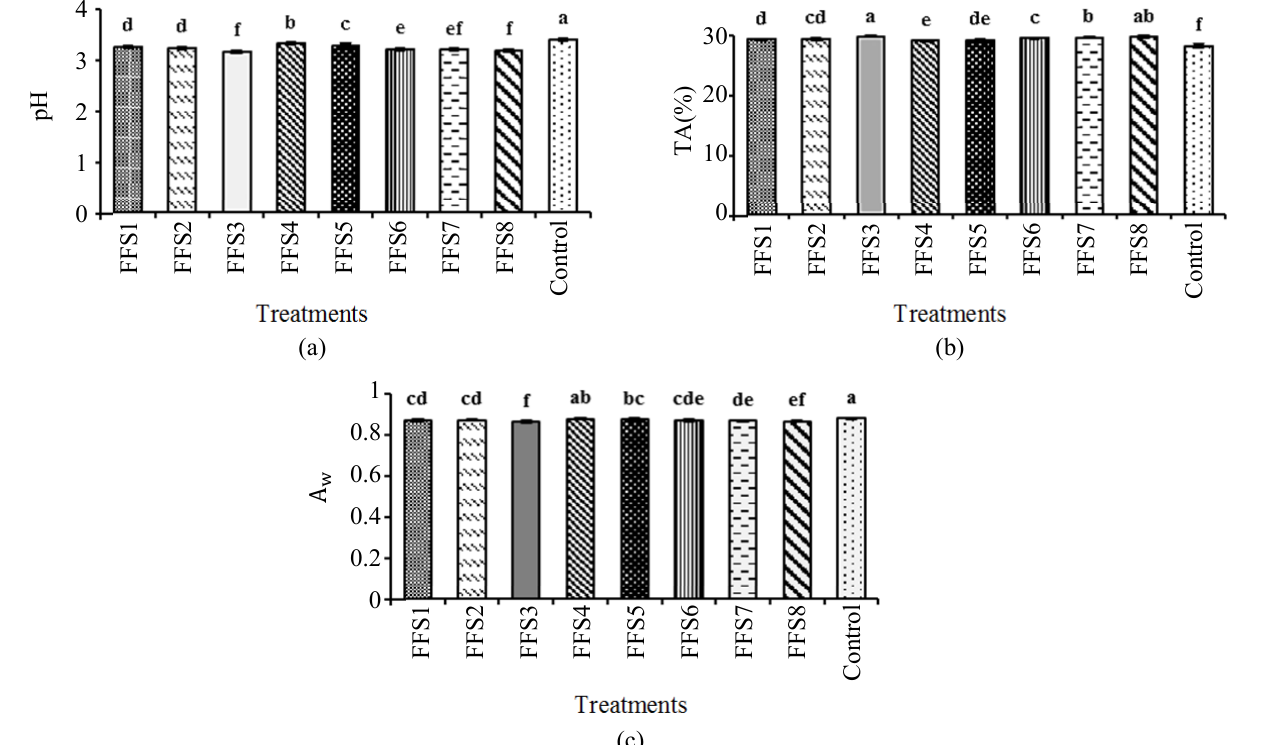
Fig. 4. Sensory acceptability scores of fortified Vietnamese tamarind fish